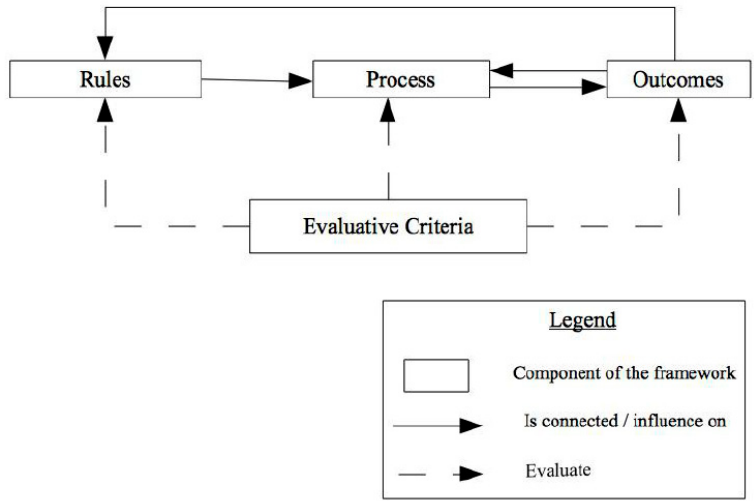
Figure 3. Institutional Analysis Framework to assess spatial justice.